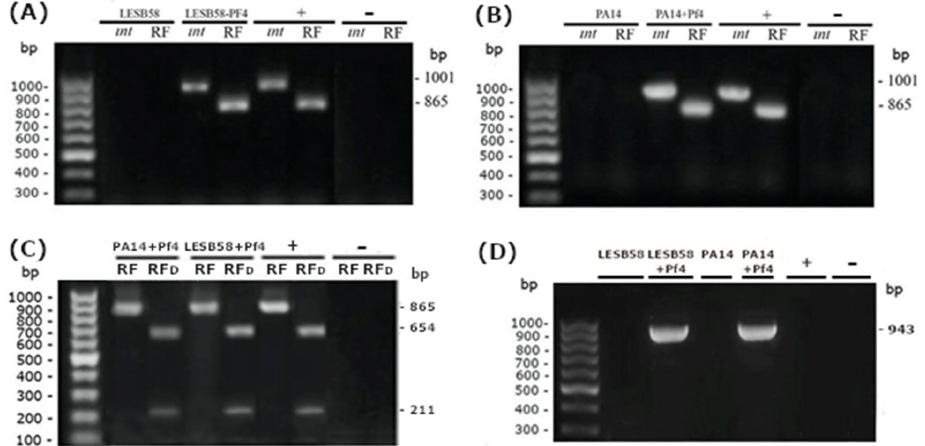
Figure 2. Confirmation of Pf4 infection of LESB58 ( A ) and PA14 ( B ) strains. Primer pairs targeting Pf4 integrase gene ( intF4 ) and replicative form (RF) were used, and expected products were obtained for Pf4 phage (bp). The obtained product for Pf4 RF was digested with HpaII enzyme ( C ) giving expected products of 654 and 211 bp. Confirmation of Pf4 bacteriophage integration in the genome of LESB58 and PA14 ( D ). The strain PAO1 was used as a positive control (+) and sterile distilled water as a negative ( ‐ ).